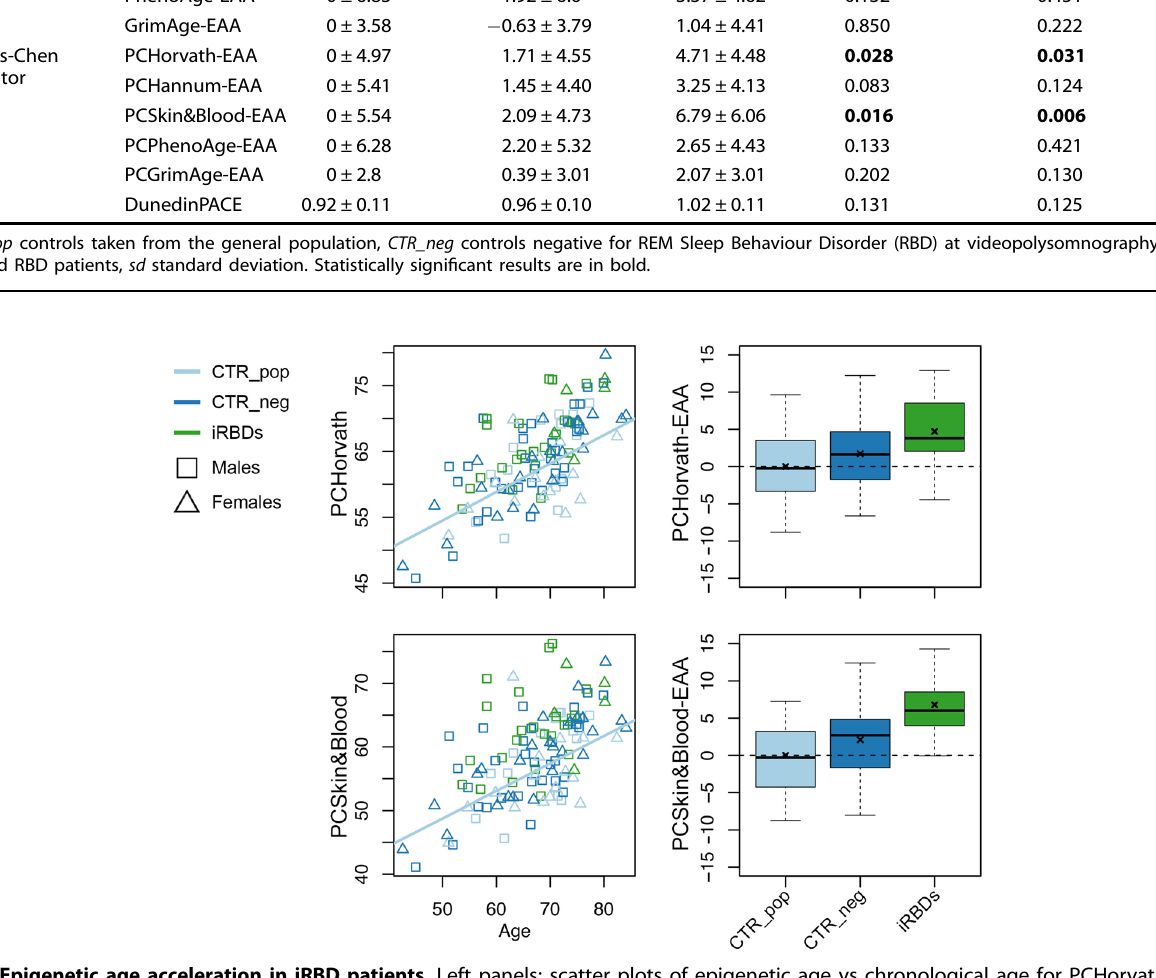
Fig. 1 Epigenetic age acceleration in iRBD patients. Left panels: scatter plots of epigenetic age vs chronological age for PCHorvath clock (upper panel) and PCSkin&Blood (lower panel). Right panels: boxplots of PCHorvath-EAA and PCSkin&Blood-EAA for the 3 groups under investigation. x: mean; central line: median; bounds of the box: 25th (lower bound) and 75th (upper bound) percentile; whiskers: minimum (lower whisker) and maximum (upper